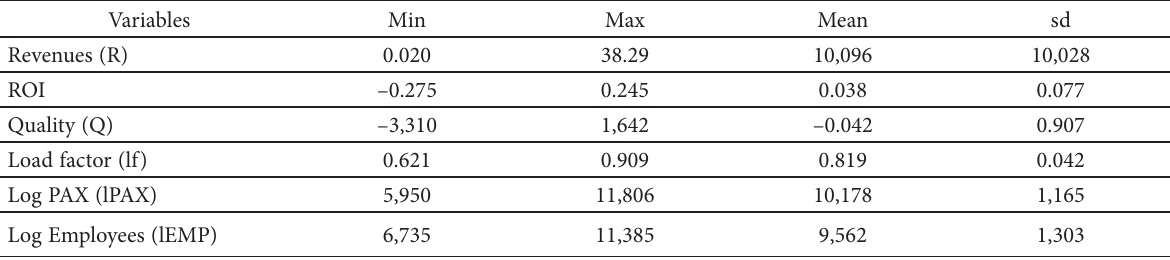
Table 2. Descriptive statistics